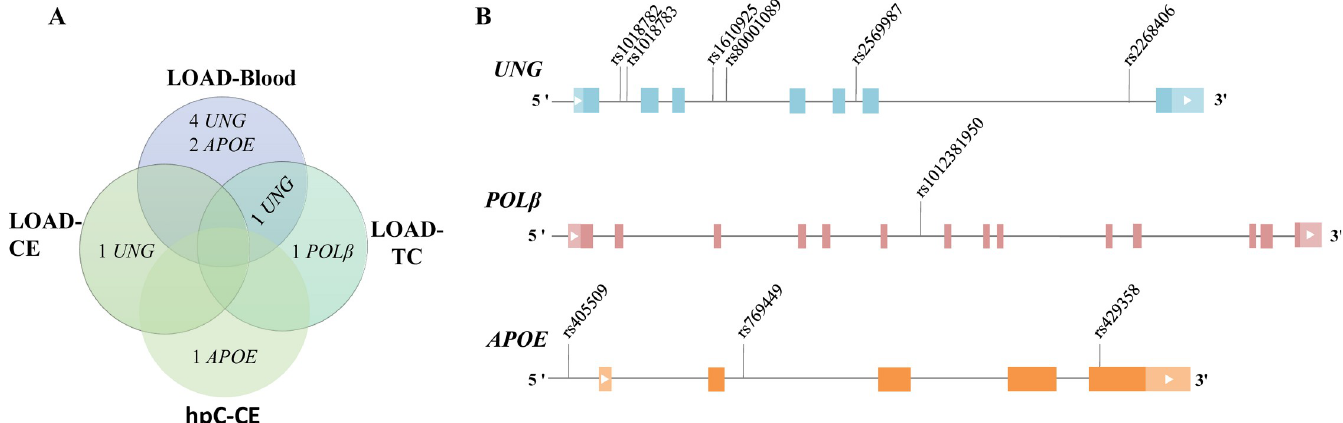
Fig 4. Comparison of statistically significant variants in all sample groups. (A) The venn diagram showing the common and unique variations between blood and post-mortem brain tissues of LOAD. (B) The location of statistically significant variants on their corresponding gene structure. LOAD, late-onset Alzheimer‘s disease; CE, cerebellum; TC, temporal cortex; hpC, high-pathology